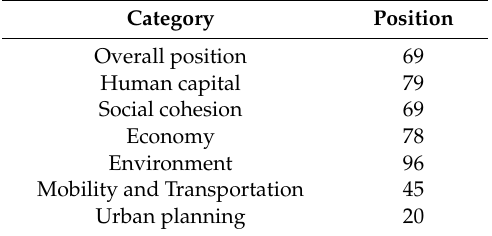
Table 3. Positions of Warsaw in IESE Cities in Motion Index (IESE CIMI) proposed as values on the quality of life axis.